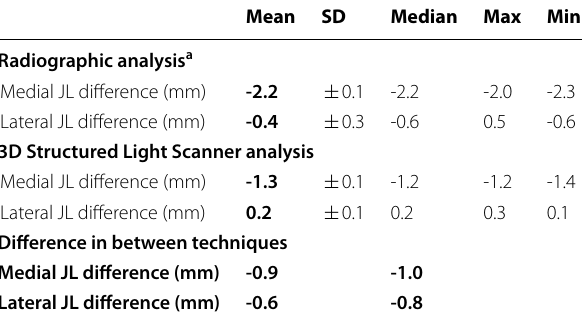
Table 1 Comparison of radiographic and 3D-surface scan measurements: JL difference pre- to